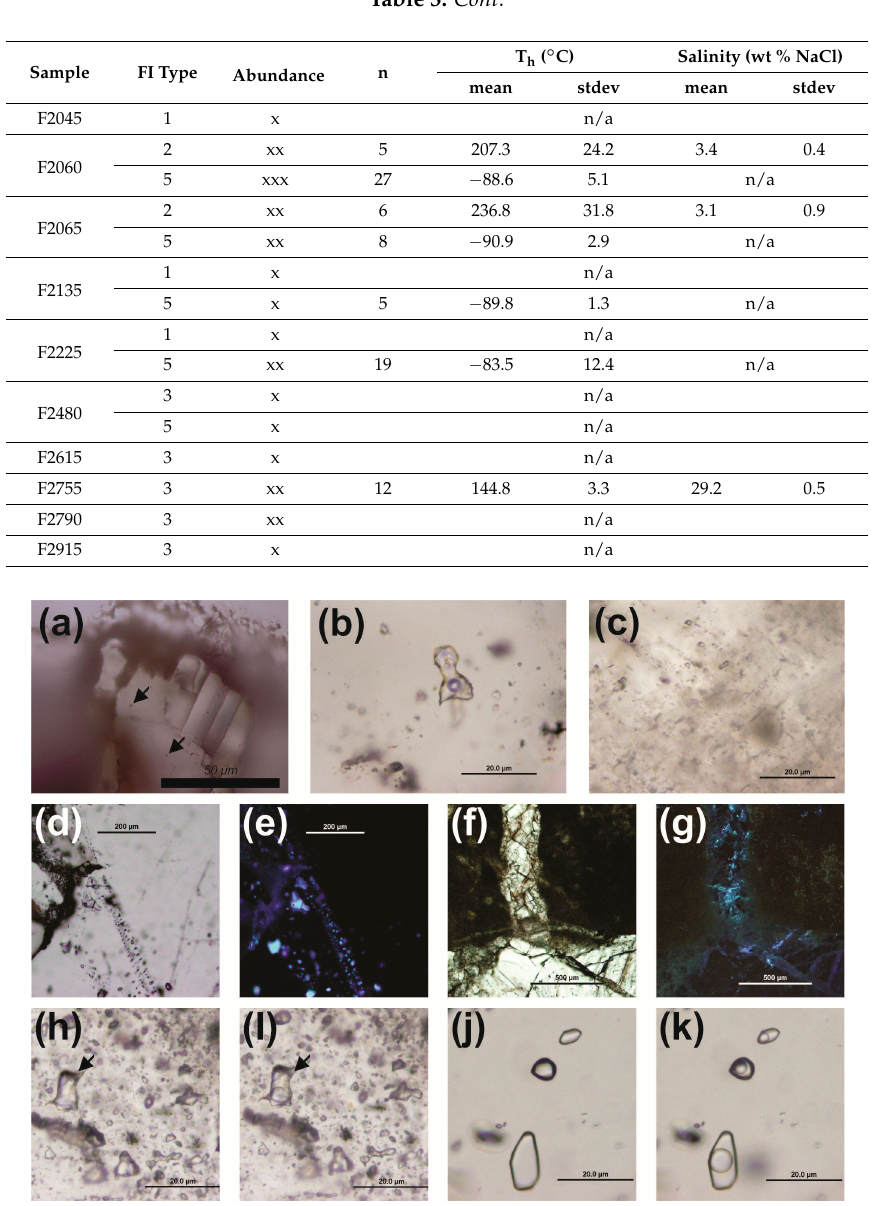
Figure 4. Photomicrographs of fluid inclusion types. ( a ) Small, monophase liquid Type 1